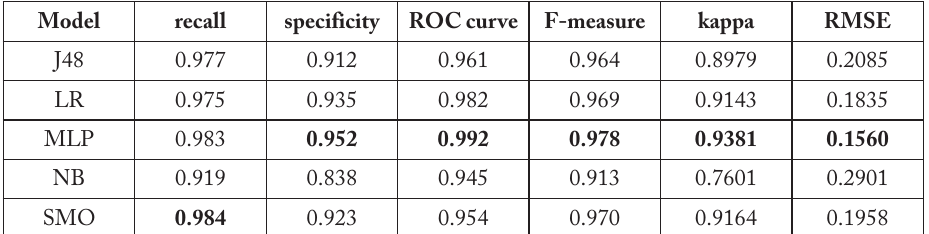
Table 3: Comparison of the models’ performance on the training dataset, using six selected metrics